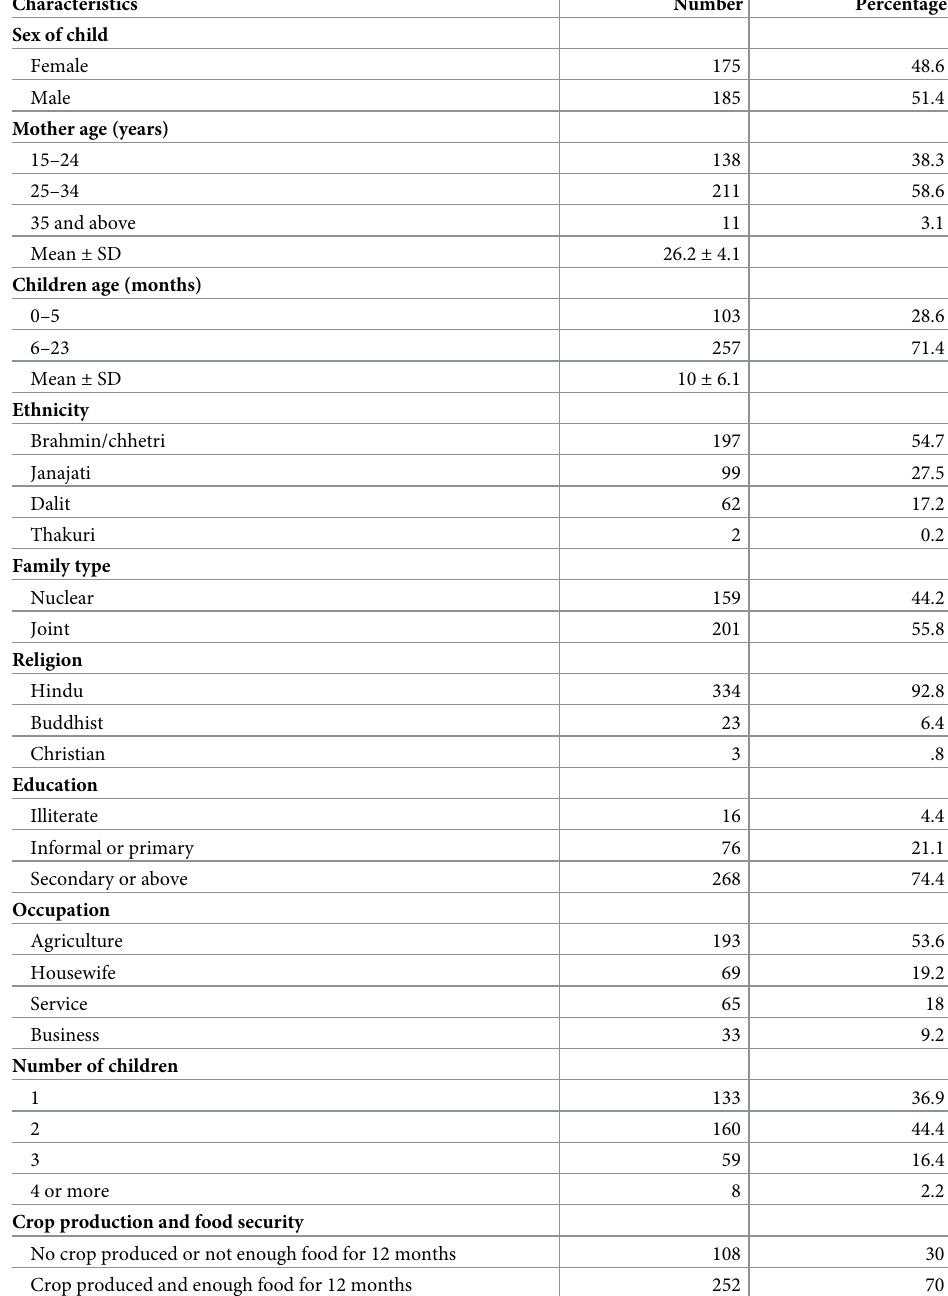
Table 1. Distribution of participants by socio-demographic